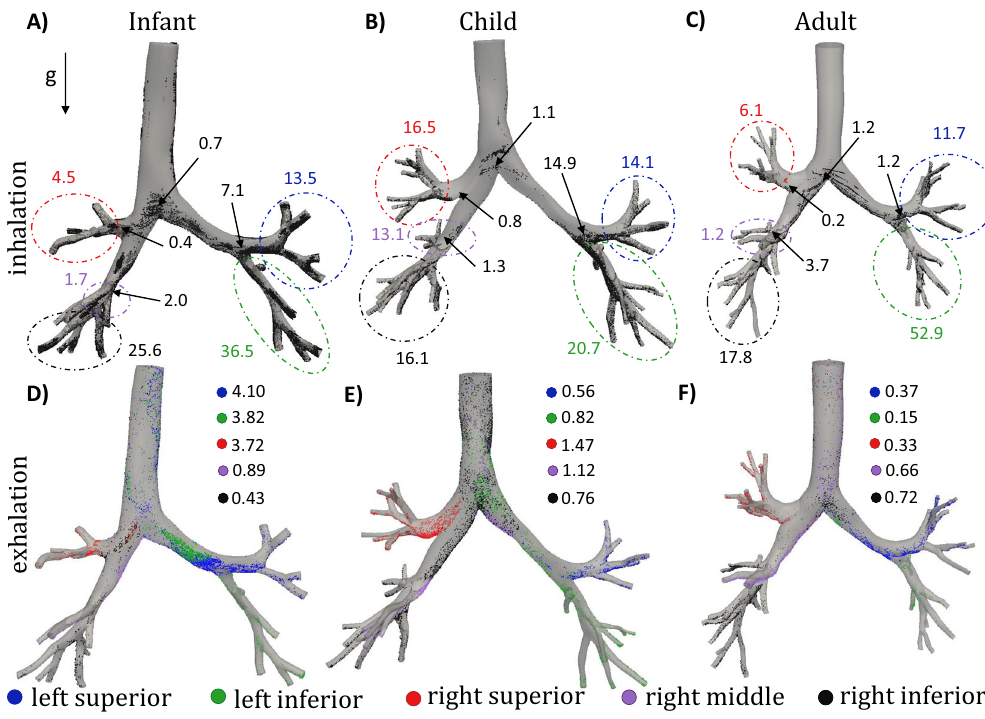
Figure 5. Deposited particle locations for infant (panels A , D ), child (panels B , E ), and adult (panels C , F ) for the 3 µ m diameter particles. Panels ( A – C ) highlight deposited hotspots for inspiration, where the values represent the regional deposition percentage (based on the number of particles depositing during inhalation only). Hotspots for expiration are shown in panels ( D – F ); the particles are color coded based on the lobe that they originated from. Presented values (panels D – F ) are the percent of deposited particles, calculated from the number of particles released back into the 3D model (not total deposition